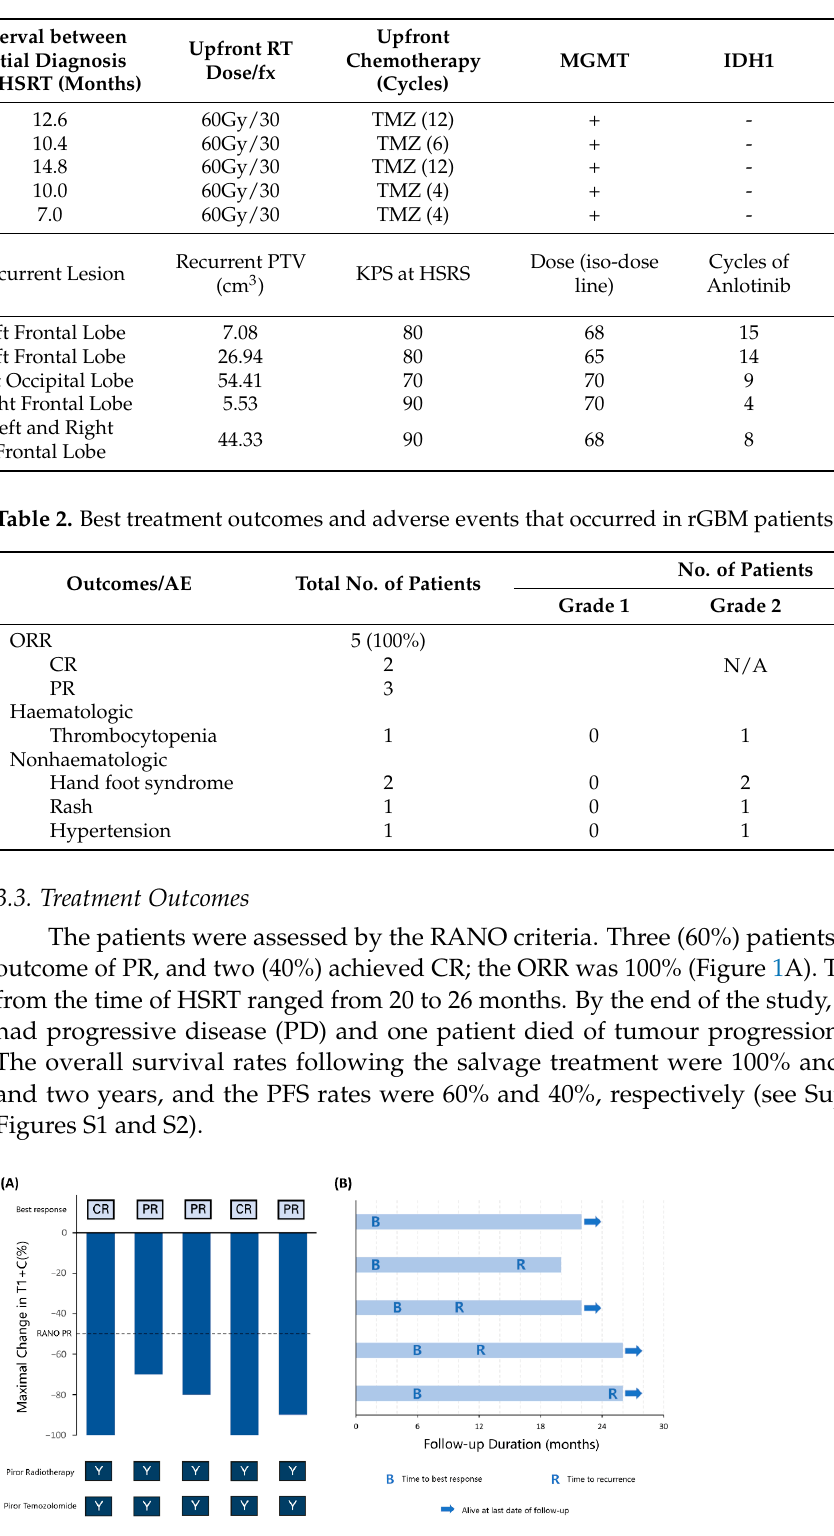
Table 1. Patient characteristics and treatment outcomes.